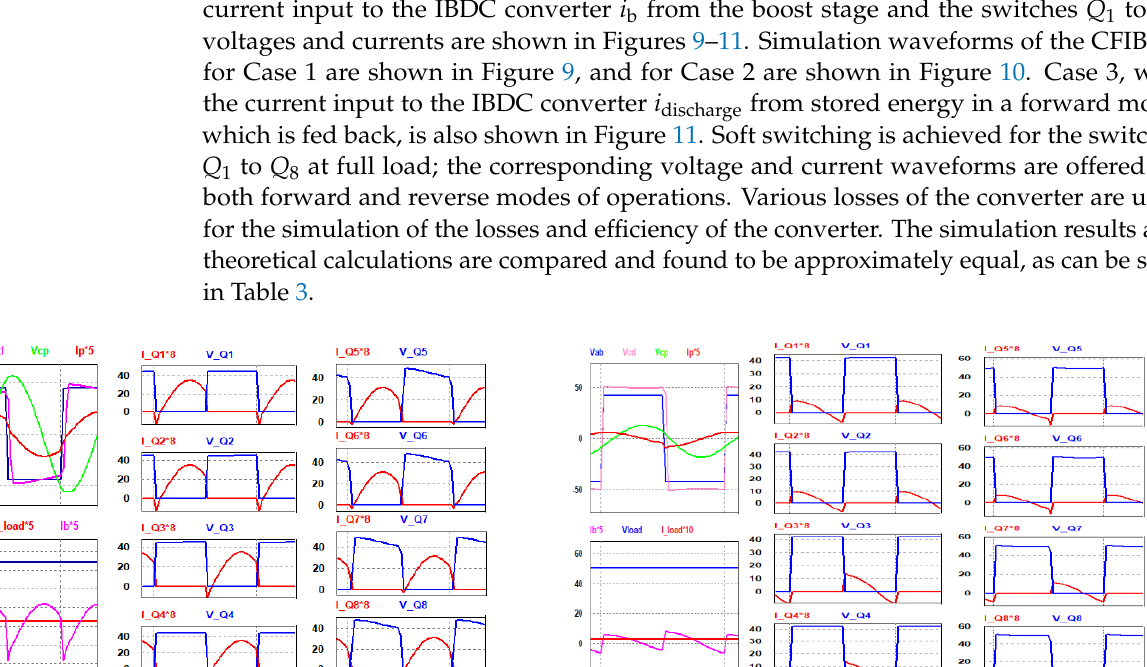
Figure 9. ( a ). Simulation results in FM mode with 100% Load at V in(min) = 12 V, v ab , v cd , i p and v cr . Soft-switching characteristics for the primary ( Q 1 to Q 4 ) and secondary side ( Q 5 to Q 8 ) switches are also shown. ( b ). Simulation results in FM mode with 10% Load at V in(min) = 12 V, v ab , v cd , i p and v cr . Soft-switching characteristics for the primary ( Q 1 to Q 4 ) and secondary side ( Q 5 to Q 8 ) switches are also shown.